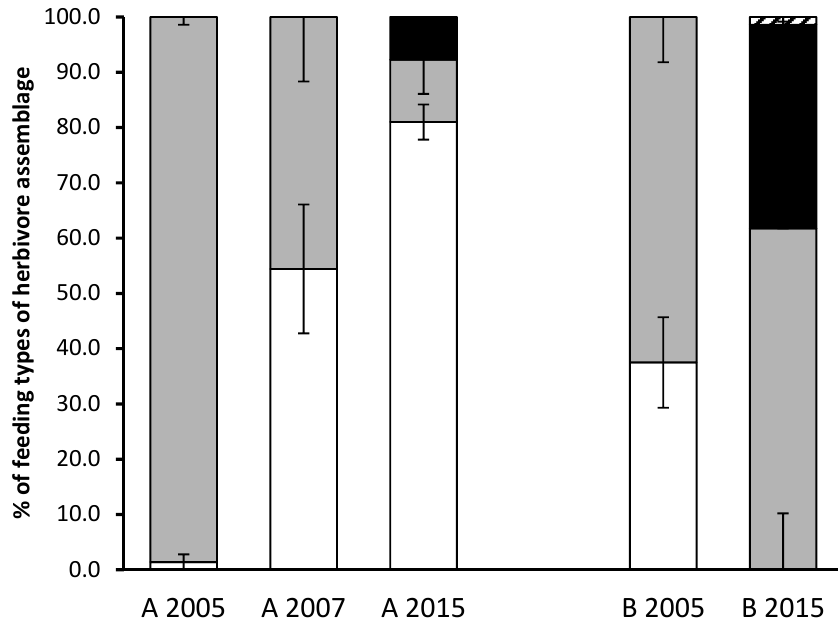
Figure 1. The percentage of the migratory endoparasites (e.g., Pratylenchus , white), ectoparasitic (e.g., Tylenchorhynchus , grey), semi-endoparasitic (e.g., Helicotylenchus , black) and ectoparasitic (e.g., Xiphenema , dashed) feeding types of the herbivorous nematodes assemblage identified from 200 mL soil samples from field A in 2005, 2007 and 2015 and field B in 2005 and 2015. Number of samples and time of year differed between years with error bars representing the standard error of the means.